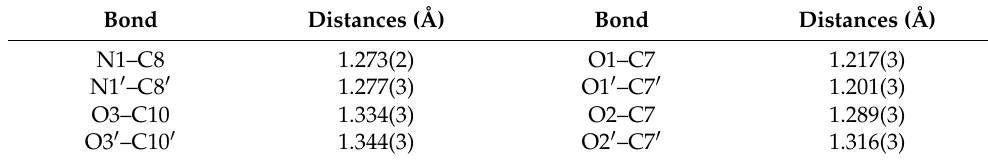
Table 1. Selected bond lengths for H 4 L.